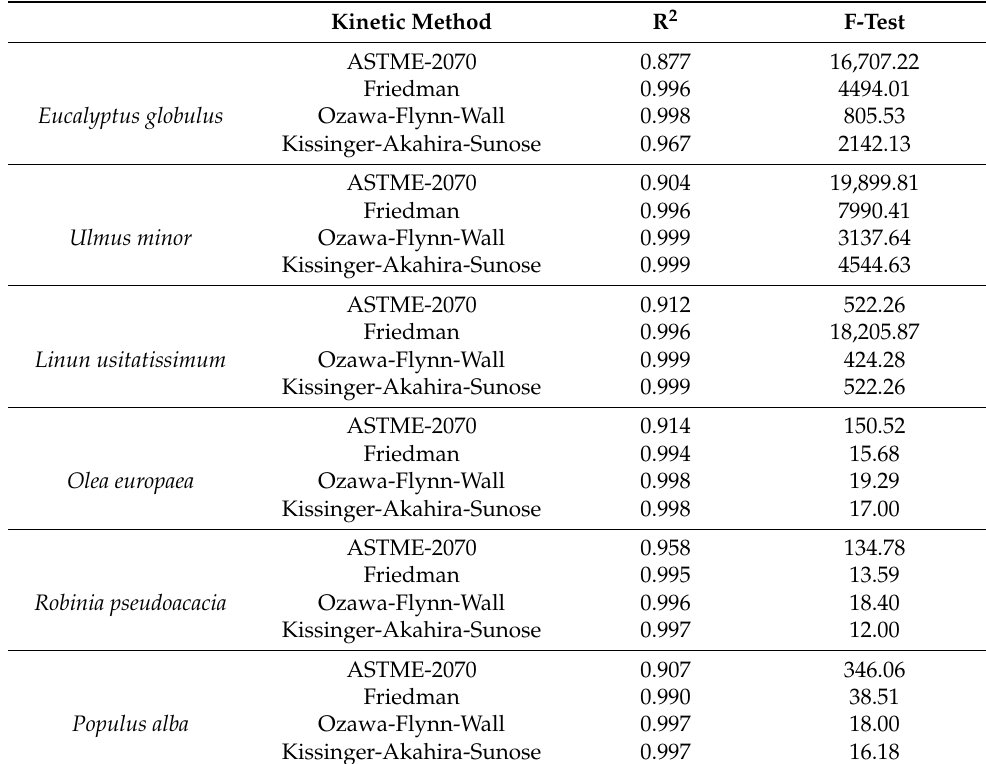
Table 3. Calculated statistical values for the different studied kinetic methods.